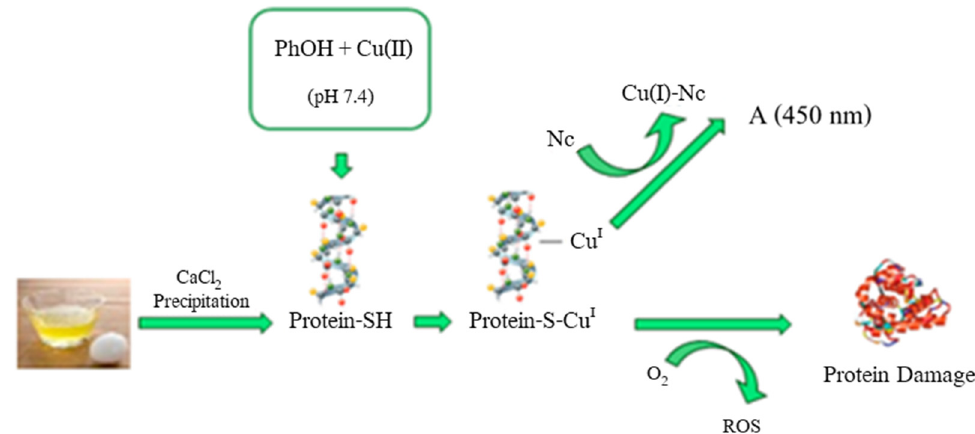
Figure 15. Schematic diagram of the proposed total pro-oxidant activity (TPA) assay using protein-based sensor. Reprinted with permission from [80]. Copyright 2021 American Chemical Society.